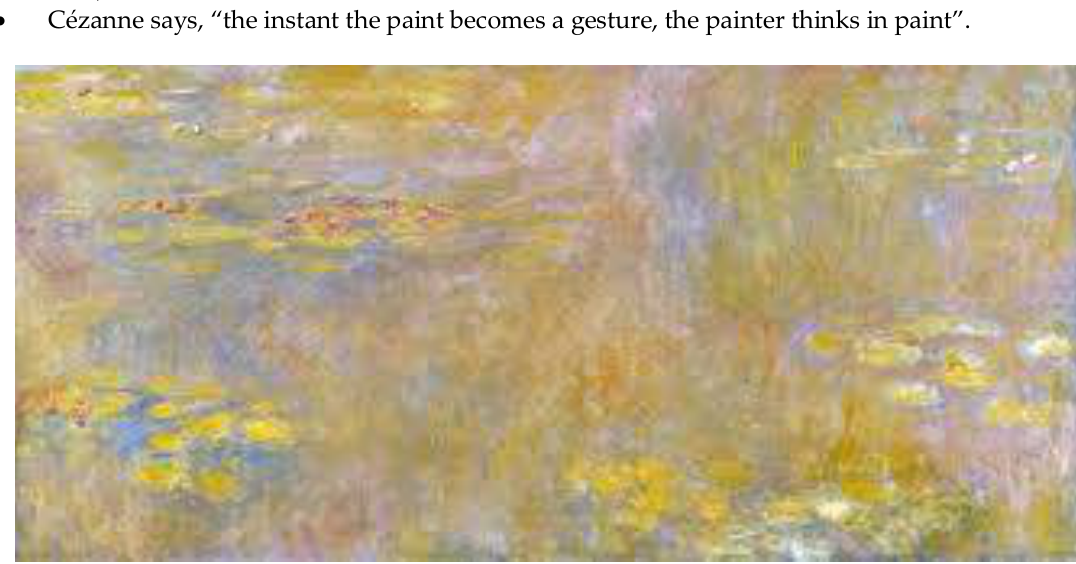
Figure 2. Claude Monet Ninfee, 1920, National Gallery,